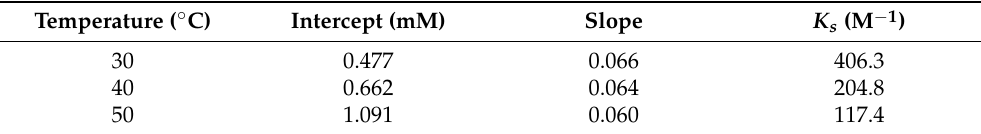
Table 3. The intercept, slope, and K s at different temperatures were obtained from the Hyp/2H- β -CD solubility diagram.